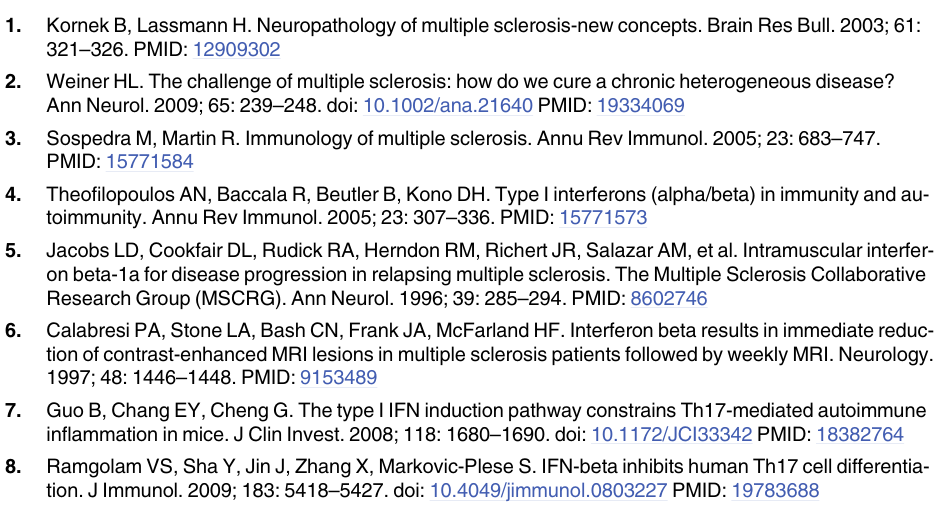
S1 Fig. Expression of genes associated with regulation, differentiation and activation of ) and T-regulatory cells in whole blood, periphery blood mononuclear cells T-helper (T H (PBMC) and in major PBMC-subsets: CD4 + T-cells (CD4Tc); CD8 + T-cells (CD8Tc); NK- cells (NK); B-cells (Bc); monocytes (Mc); dendritic cells (Dc). Samples were obtained from 4 untreated and 4 interferon-(IFN) β treated patients with relapsing remitting multiple sclerosis (RRMS; sub-study 4 population). IFN- β -treated patients were sampled 36 – 48 hours after their last injection of IFN- β ; PBMC-subsets were isolated by immunomagnetic labeling and separa- tion. Gene expression is given as normalization ration (NR), boxes represent inter-quartile range, median value indicated as a line; whiskers represent range. Due to low sample size, data given are descriptive and were not tested statistically. ¥ = gene expression was measurable in only 2 or less samples. S1 Table. Targets used in gene expression analysis by PCR. S2 Table. Antibodies and other reagents used to stain cells for flow cytometry